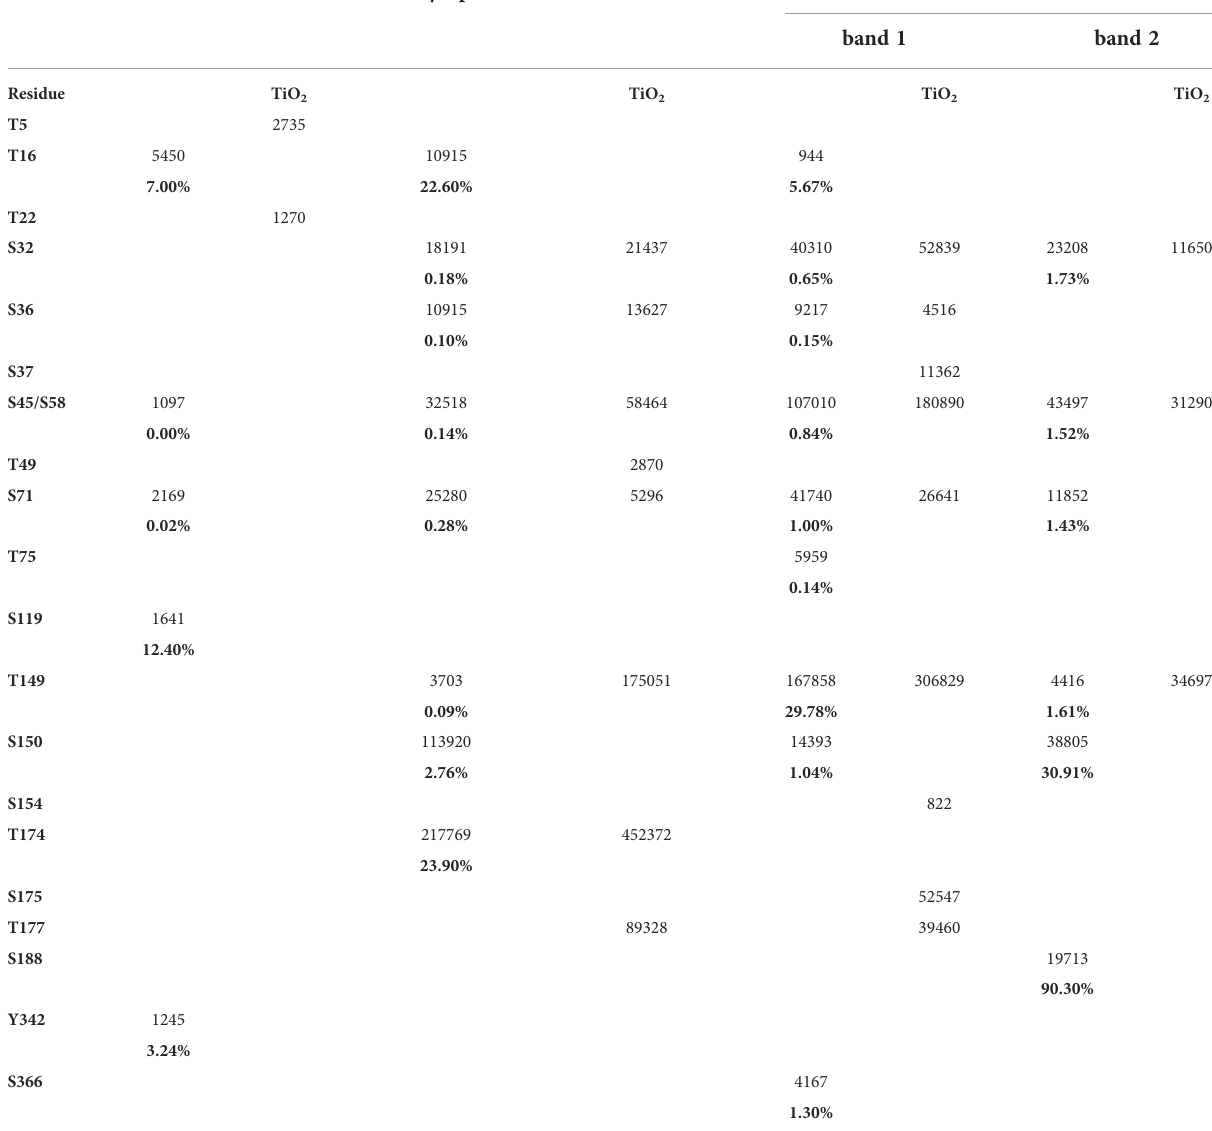
TABLE 2 Phosphoproteomic analysis of the N-terminus of